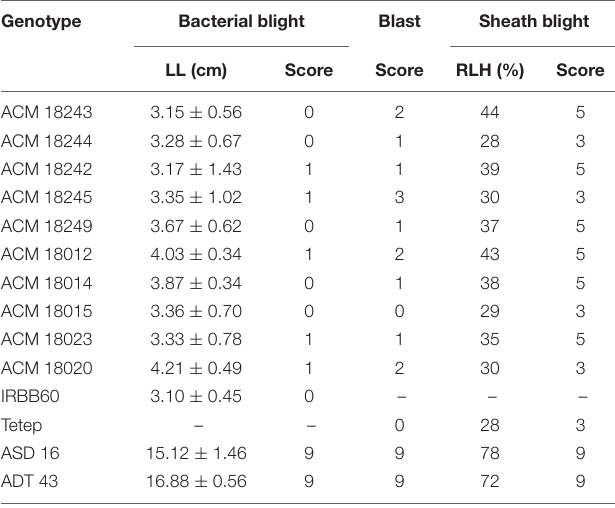
TABLE 2 | Phenotypic reaction and disease score of improved pyramided lines against bacterial blight (BB), blast, and sheath blight